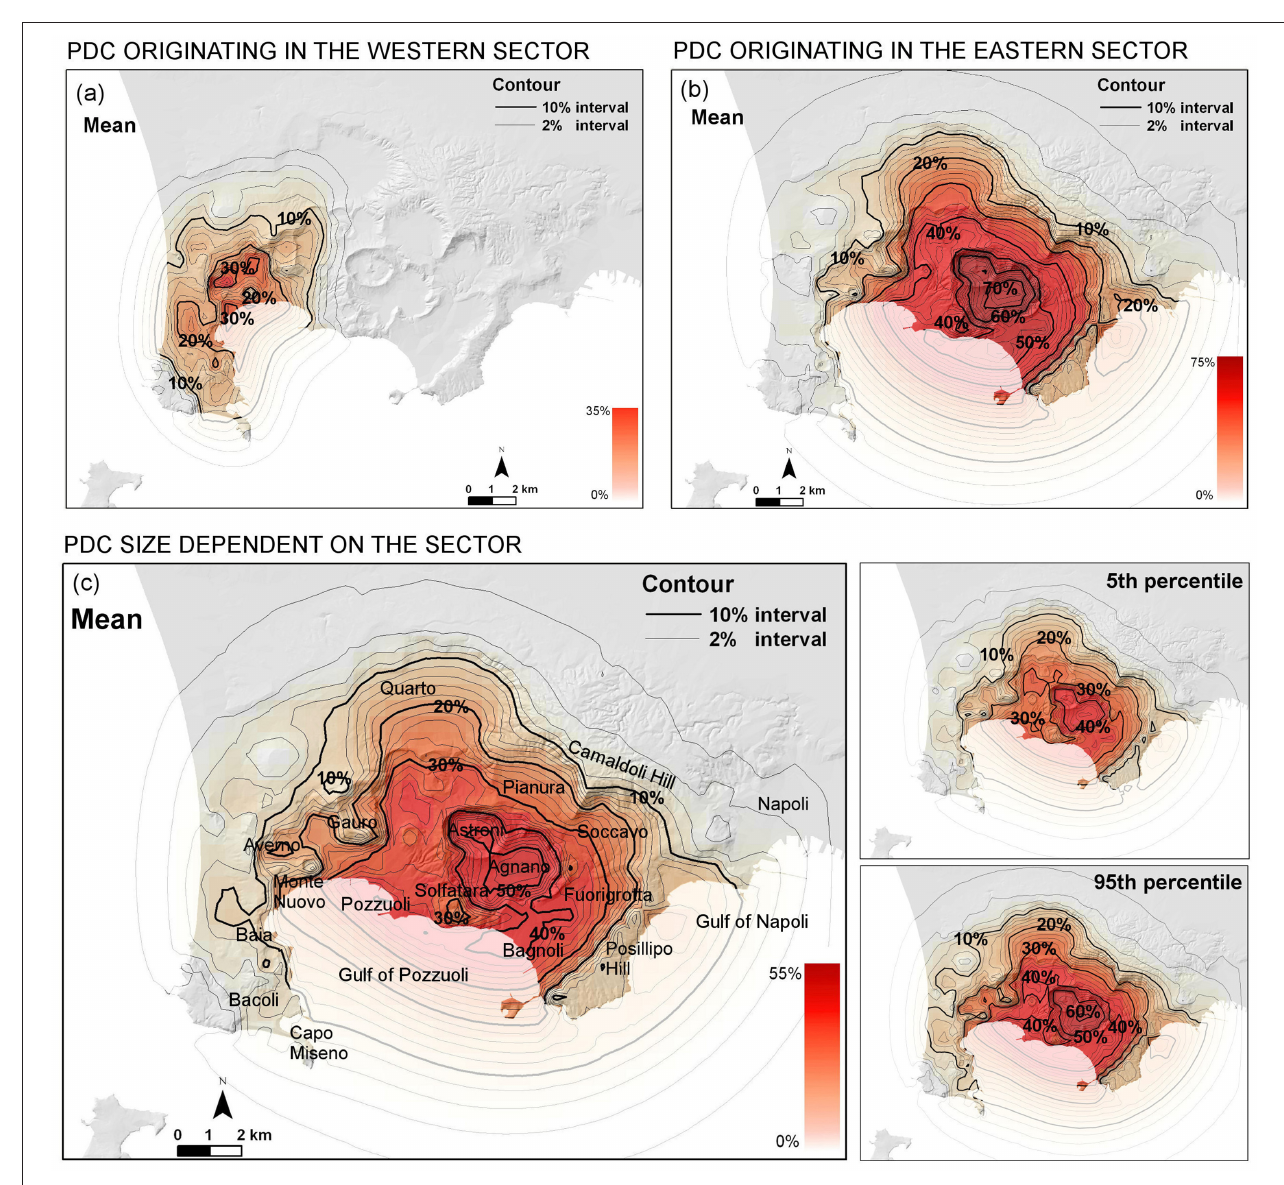
FIGURE 4 | PDC invasion hazard maps based on the areal size distributions and vent opening probability maps displayed in Figure 3 . Contours and colors indicate the mean percentage probability of PDC invasion conditional on the occurrence of an explosive event— (a) originating on-land in the western sector, (b) originating on-land in the eastern sector, (c) originating on-land according to the vent opening map in Figure 2 , but with the PDC invasion area distribution depending on the sector of the vent location. The two maps on the right of the average map (c) show the 5th and 95th uncertainty percentiles of the distribution by using the same color